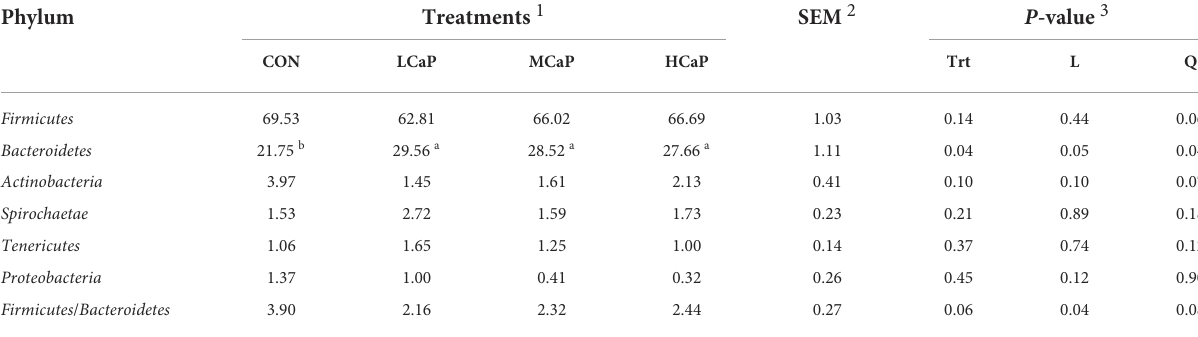
TABLE 3 Effects of calcium propionate feeding levels on the relative abundances (%) of major fecal bacterial communities at the phylum level (averagely accounting for ≥ 0.5% of the total sequences in at least one treatment) of dairy cows in early lactation. Phylum Treatments